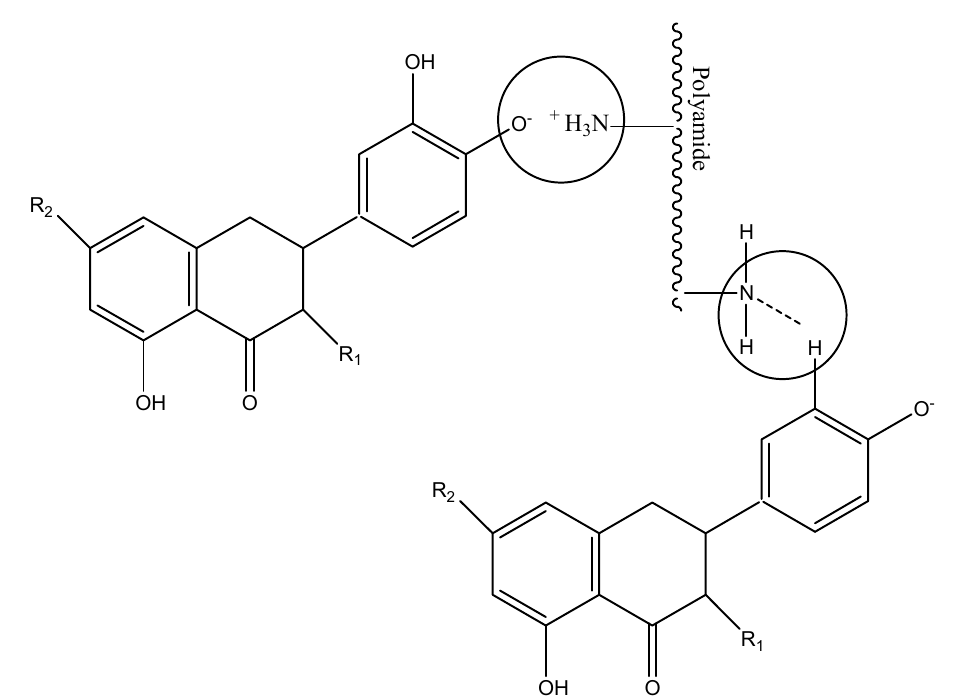
Figure 3. Electrostatic interactions and hydrogen bond between positively charged end amino groups of polyamide and flavonoids of the dye (pH = 3).